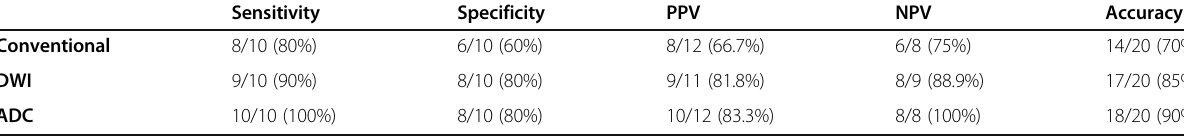
Table 5 Diagnostic indices (sensitivity, specificity, PPV, NPV, and accuracy) of MRI (conventional, DWI, and ADC) in the studied